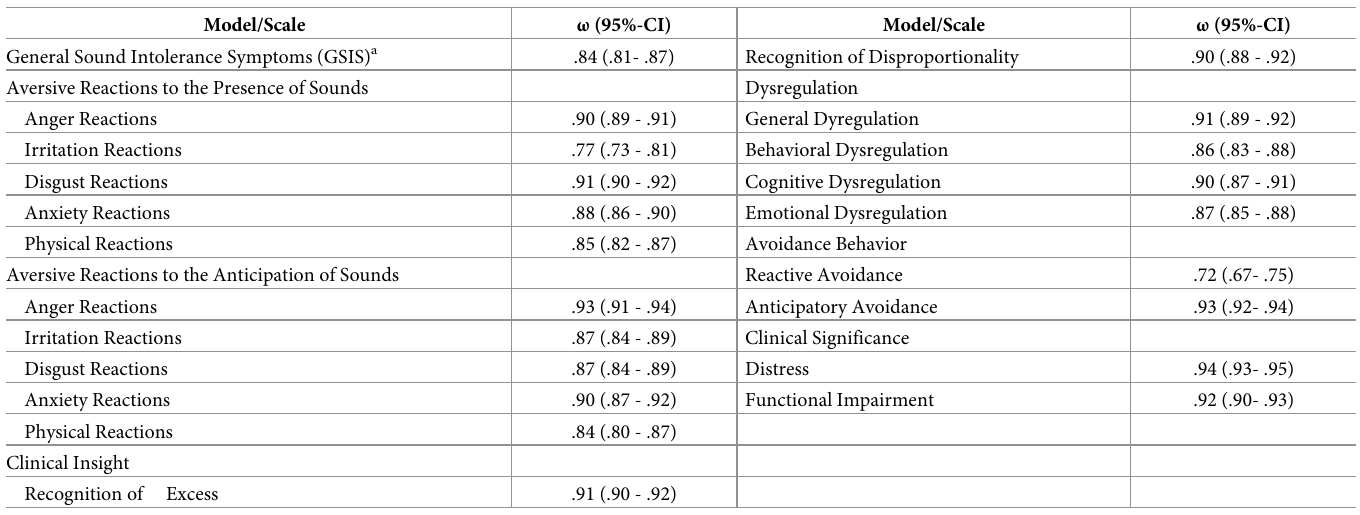
Table 3. Reliability estimates for the BMQ-R